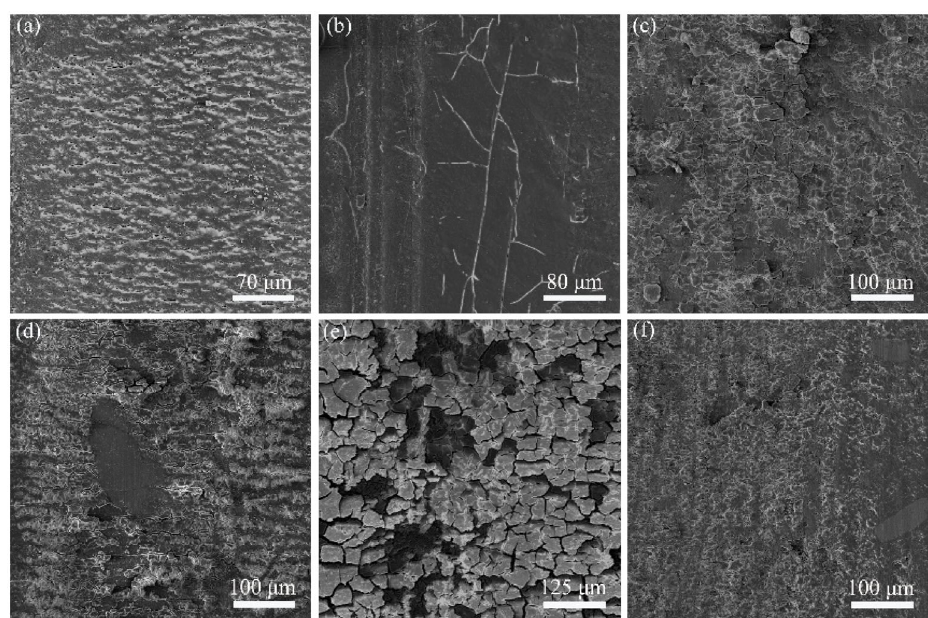
Fig. 9 SEM images of the worn surfaces of (a) epoxy resin and epoxy–Ti 3 C 2 3DNS composites with (b) 0 g, (c) 0.5 g, (d) 1.0 g, (e) 2.0 g, and (f) 3.0 g few-layer Ti 3 C 2 MXene